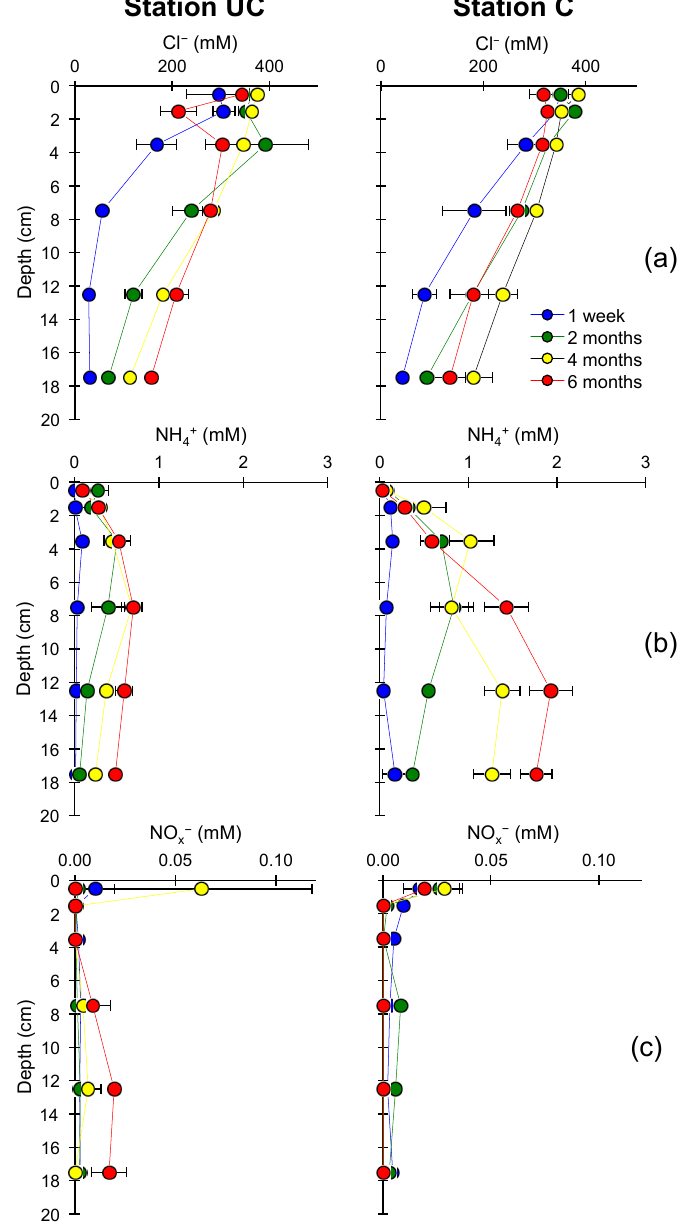
Figure 1. Depth profiles of: ( a ) chloride (Cl − ); ( b ) ammonium (NH 4+ ); and ( c ) nitrate + nitrite (NO x − ) concentrations in porewater at each time point at the uncultivated (UC) and cultivated (C) stations. Error indicated as standard error of mean (SEM) ( n = 3).